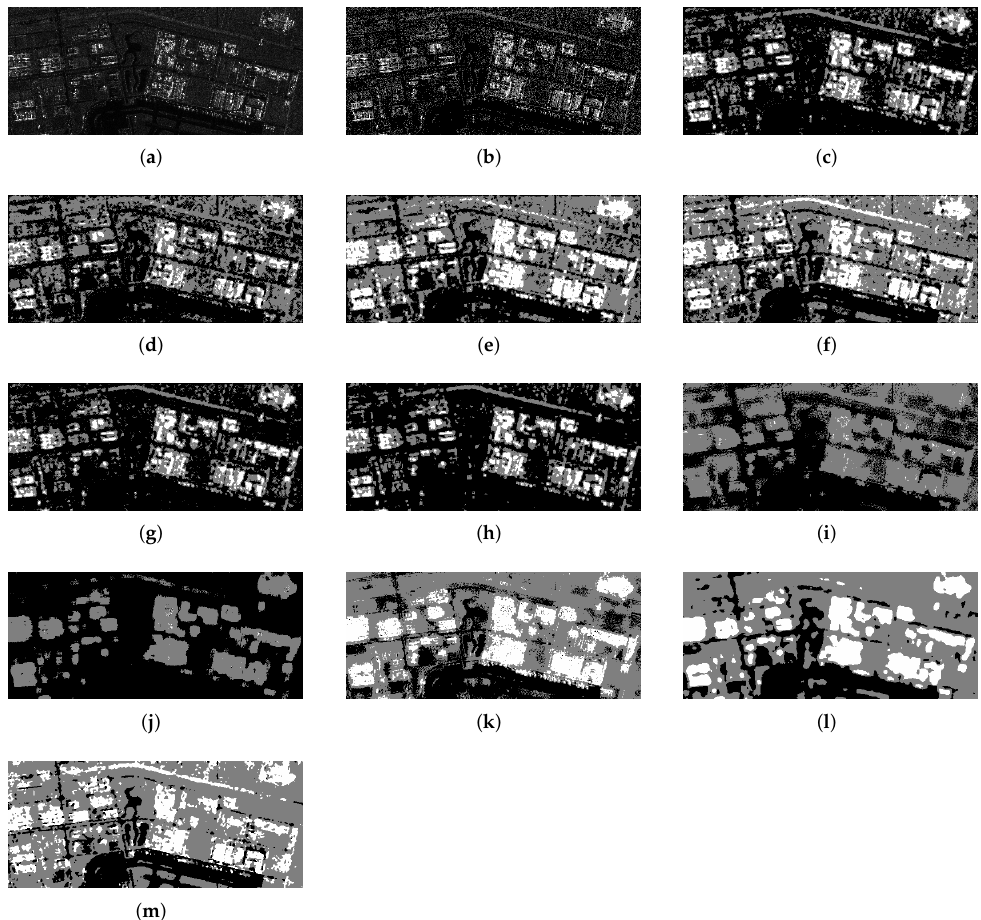
Figure 16. Segmentation results of each algorithm on GaoFen-3 SAR Image. ( a ) Original image. ( b ) FCM. ( c ) FCM_S1. ( d ) FCM_S2. ( e ) KFCM_S1. ( f ) KFCM_S2. ( g ) EnFCM. ( h ) FGFCM. ( i ) FCM_NLS. ( j ) NS_FCM. ( k ) RFCM_BNL. ( l ) LBNL_FCM. ( m )